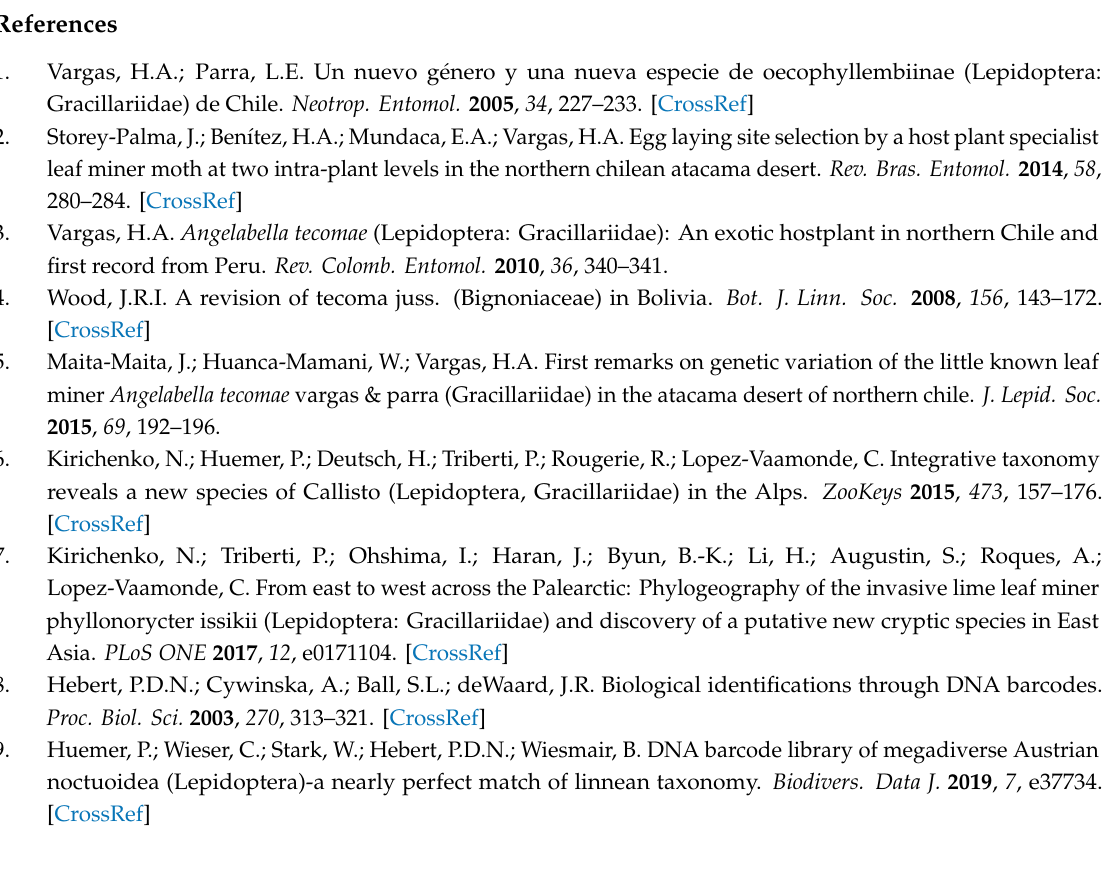
Figure S1: Results of Geneland analyses. A. Number of clusters along the chain after burn-in. B. Map of posterior probability to belong to clusters 1-4 (indicated by dark colors), Figure S2: Graphical results of the ABGD analysis. A. Histogram of pairwise Kimura 2-parameter distances for the COI marker, showing three barcode gaps. B. Ranked pairwise distances. C. Number of groups for partitions per value of prior intraspecific divergence, Figure S3: Results of the st-GMYC analysis. A. Number of lineages over time (years) (red vertical line indicates the threshold time between inter- intraspecific branching). B. Likelihood surface through time. C. Tree with species delimited (indicated by red branches), Figure S4: Results of the bPTP analysis. A. Highest Bayesian supported solution. B. Delimitation supports for candidate species (CS) of Angelabella